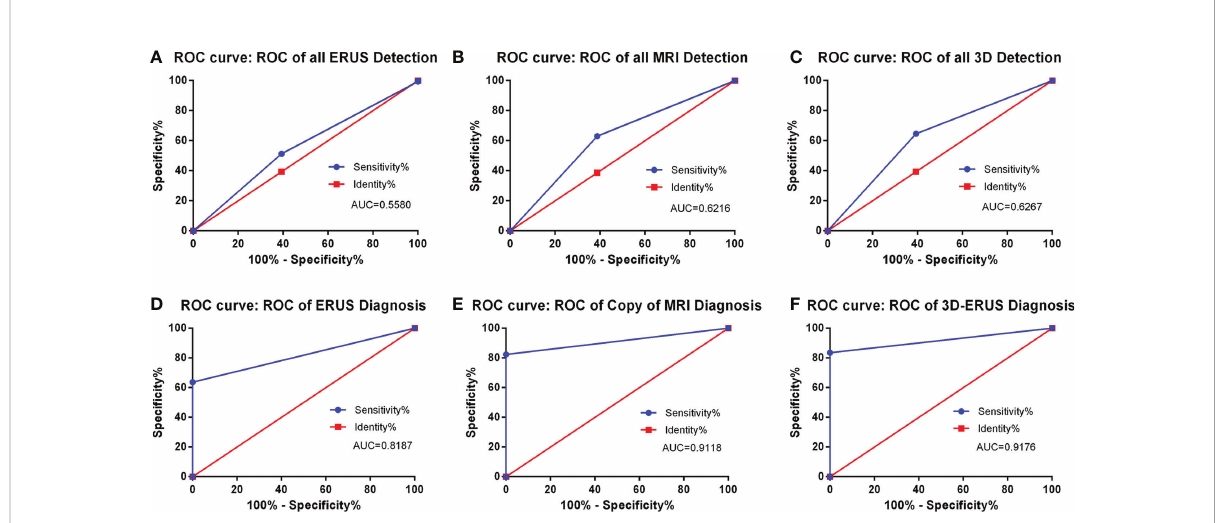
FIGURE 5 The detection and diagnosis rate of prostate cancer by different diagnostic methods. (A) : the ROC curve of all TRUS detection; (B) the ROC curve of all MRI detection; (C) the ROC curve of all 3D-TRUS detection; (D) the ROC curve of TRUS diagnosis; (E) the ROC curve of MRI diagnosis; (F) the ROC curve of 3D-TRUS